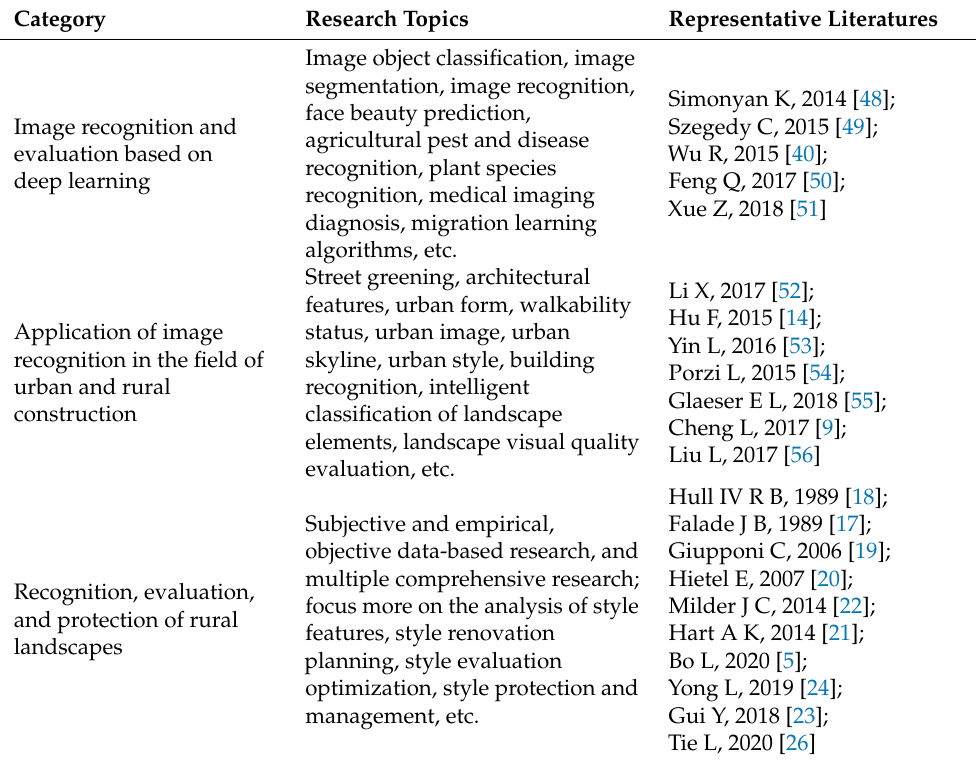
Table 2. A list of these existing literatures by three categories.